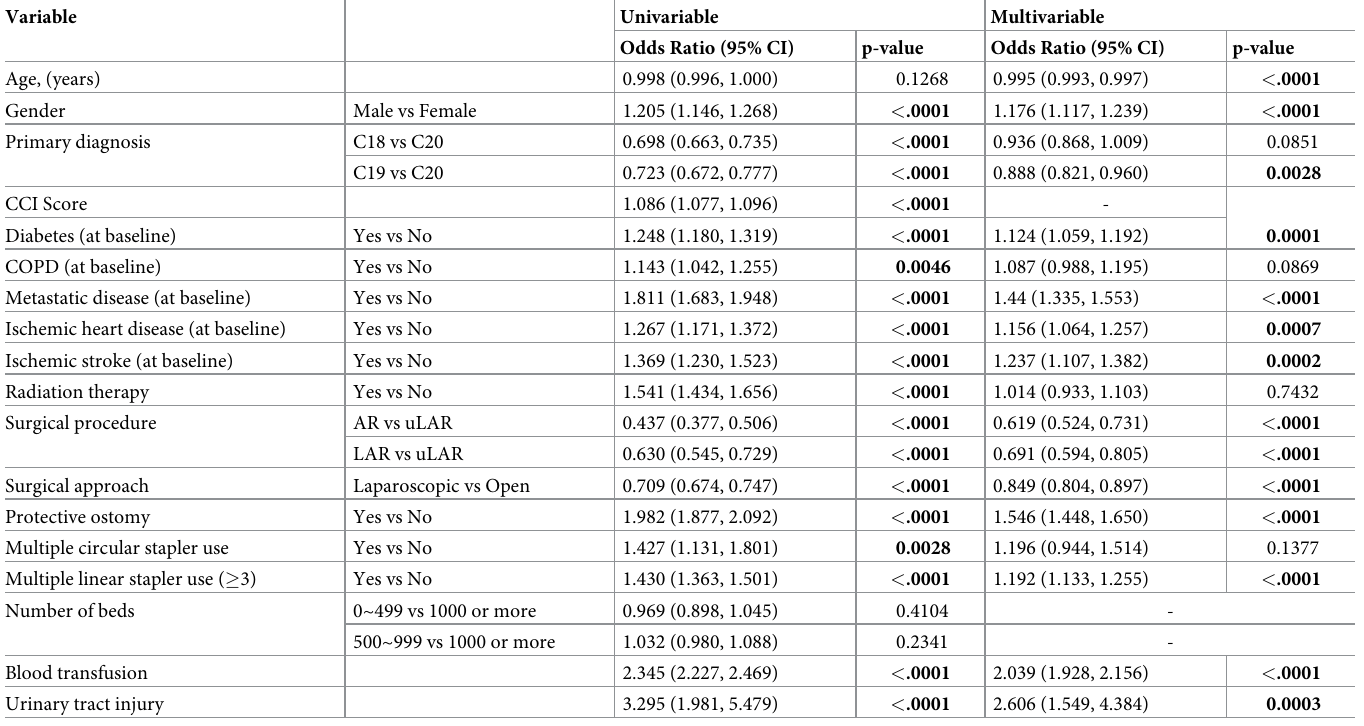
Table 3. Risk factors and clinical parameters associated with the anastomotic leak from logistic regression.